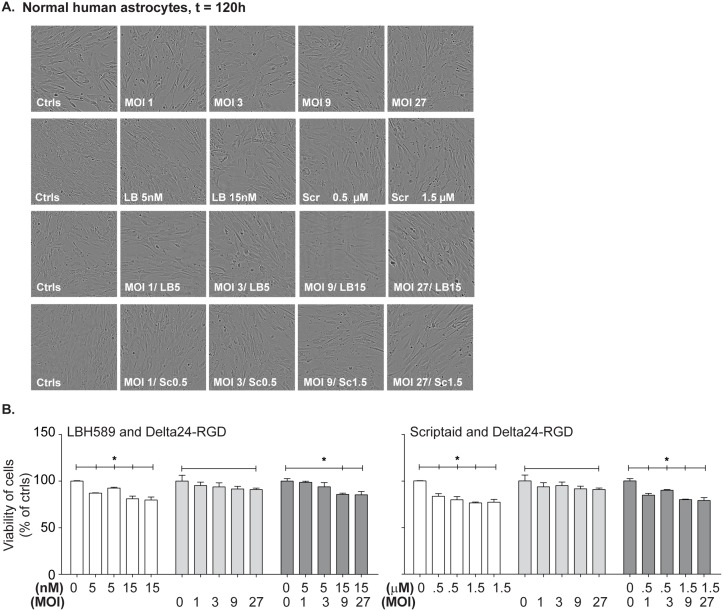
The effects of HDACi/Delta24-RGD on normal human astrocytes.(A) Normal human astrocytes were concomitantly treated with a dose range of HDACi and Delta24-RGD and monitored for morphological changes using the IncuCyte imaging system. Representative images at day five are depicted (10X magnification) for the tested conditions. (B) Viability of the cells was measured at day five post-treatment using the CellTiter-Glo assay, and the results are shown as percentage of non-treated control cells ± standard deviation. *Indicates significance at p<0.05 of the treated cells compared to the non-treated control cells.